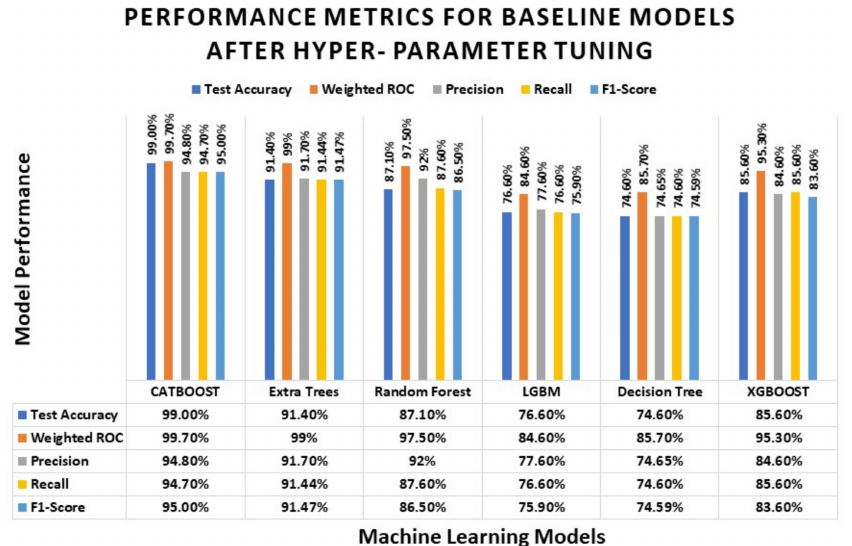
Figure 9. Baseline model performance comparison over all the performance metrics after hyper- tuning the parameters.